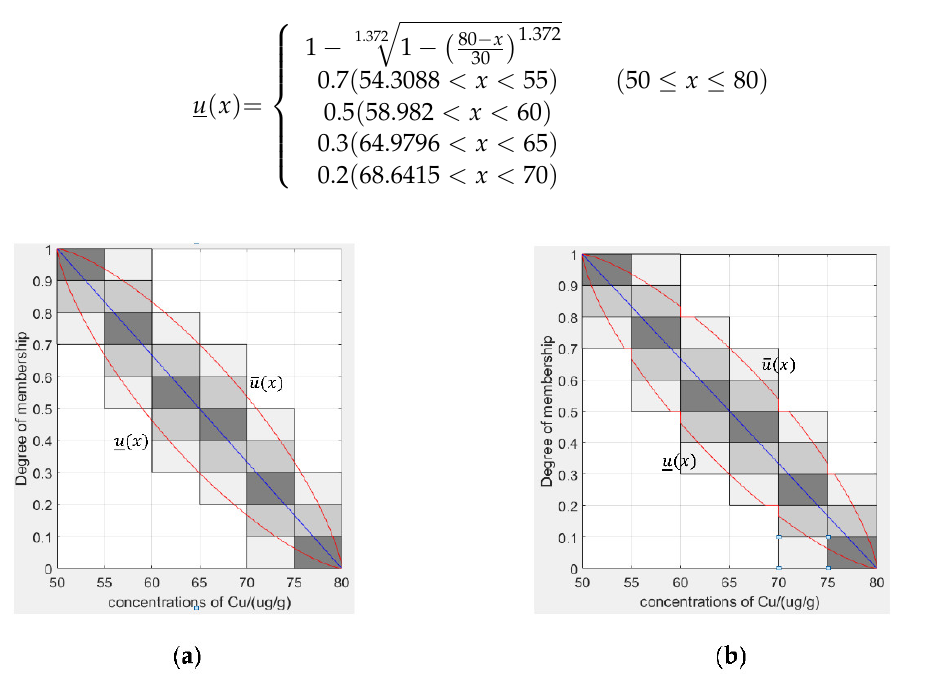
Figure 6. Granular type-2 fuzzy membership function when = 1.372.